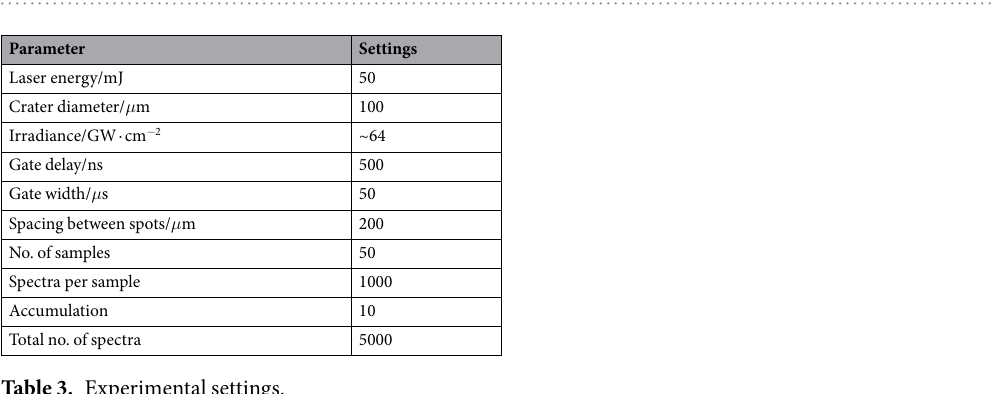
Table 3. Experimental